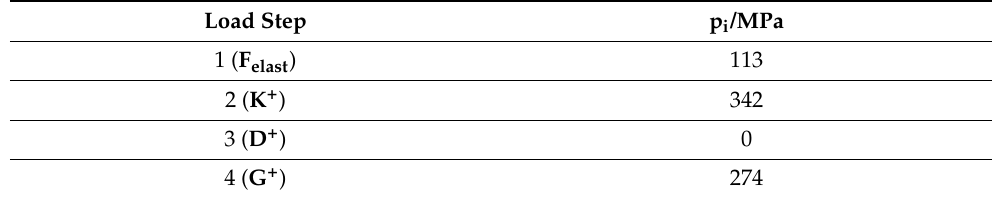
Table 4. Load steps of the load history with hardening of the material, according to Figure